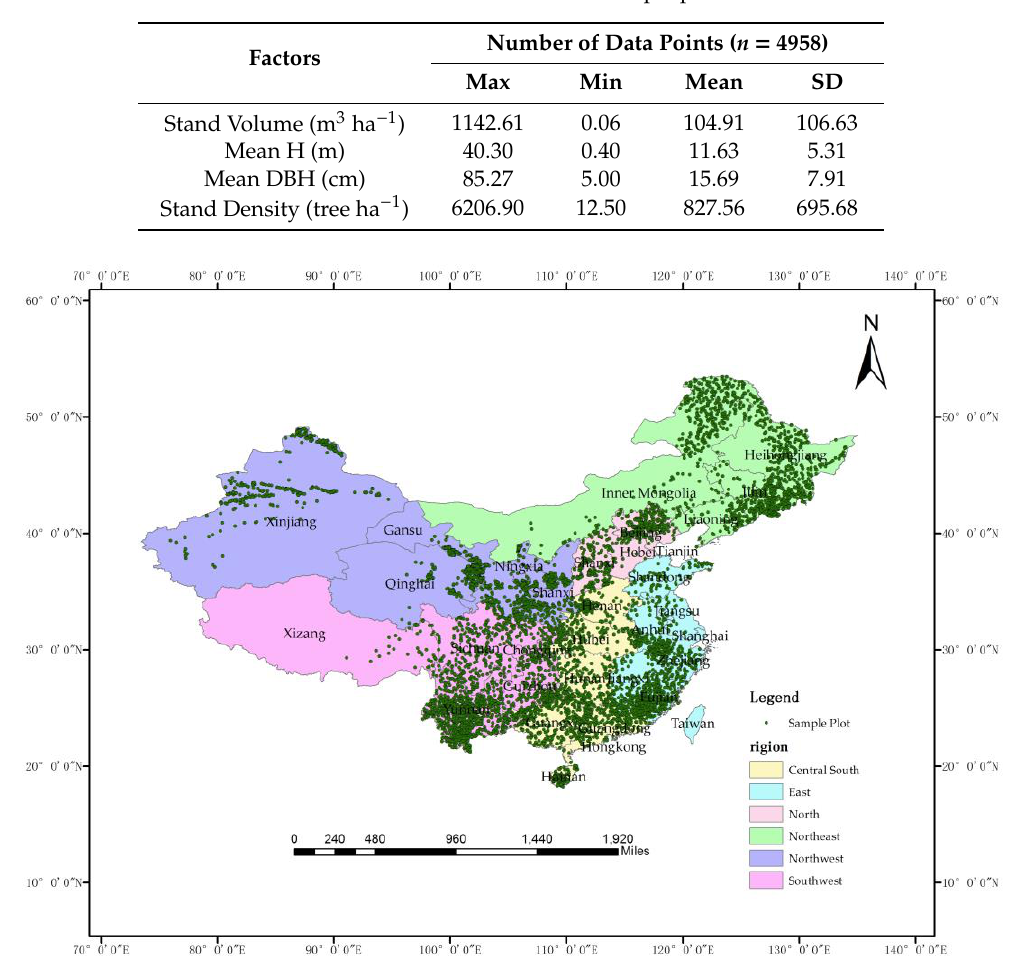
Table 1. Statistical indicators of sample plots.